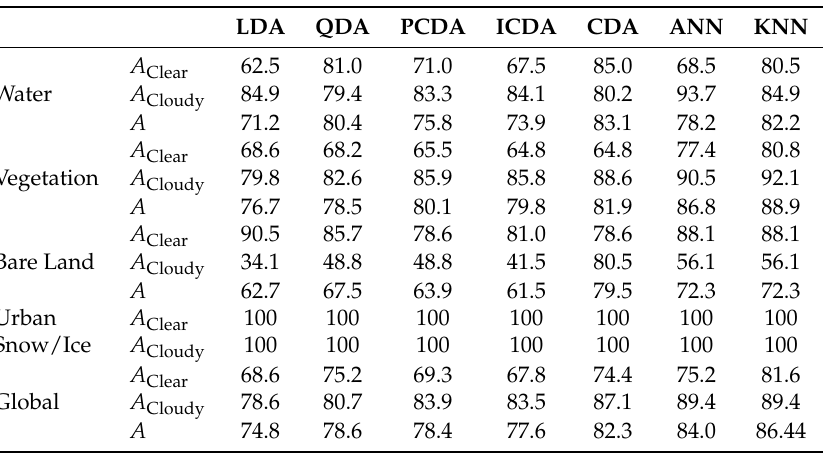
Table 6. Accuracy indicators A , A Clear and A Cloudy of classification methods when validation is made on the gold standard dataset of Section 2.2 and no ancillary information on surface or climate is used. Percentage values are reported for the entire gold standard dataset (row Global) and sorted for different surface types.